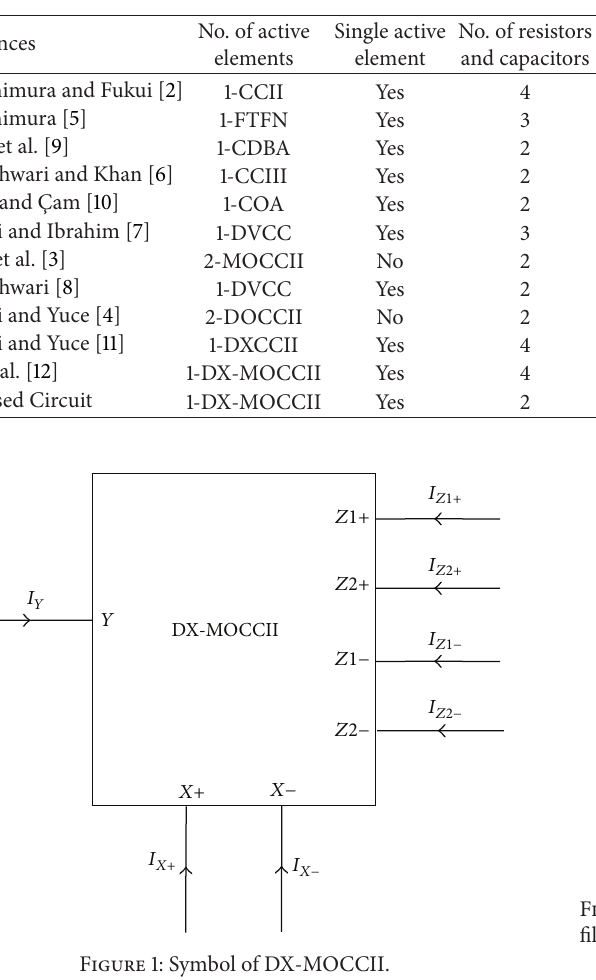
Table 1: Comparison of various current-mode all-pass filters.